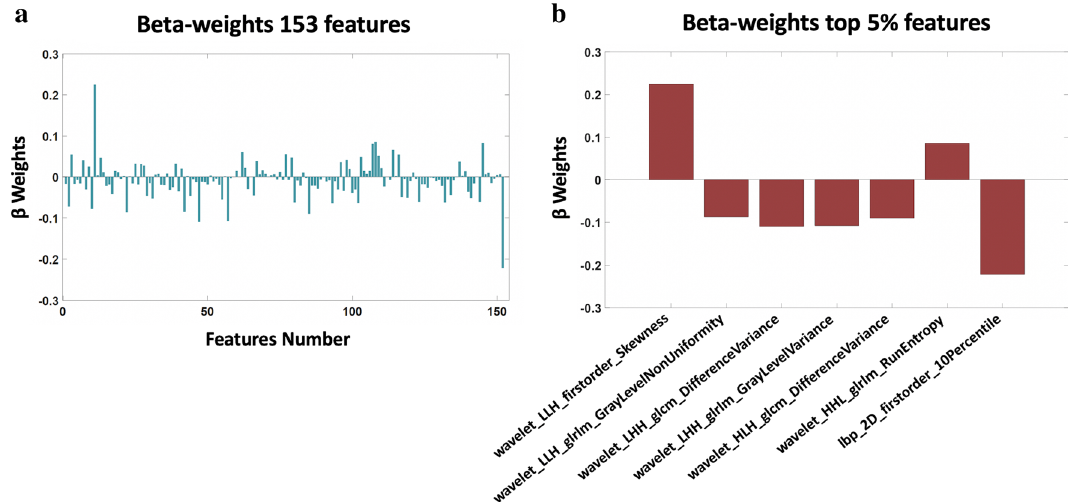
Figure 4. ( a) Partial least square β-weights associated with reliable (r > 0.95) radiomics features. ( b ) β-Weights associated to the top 5% of features with the largest β-weights in